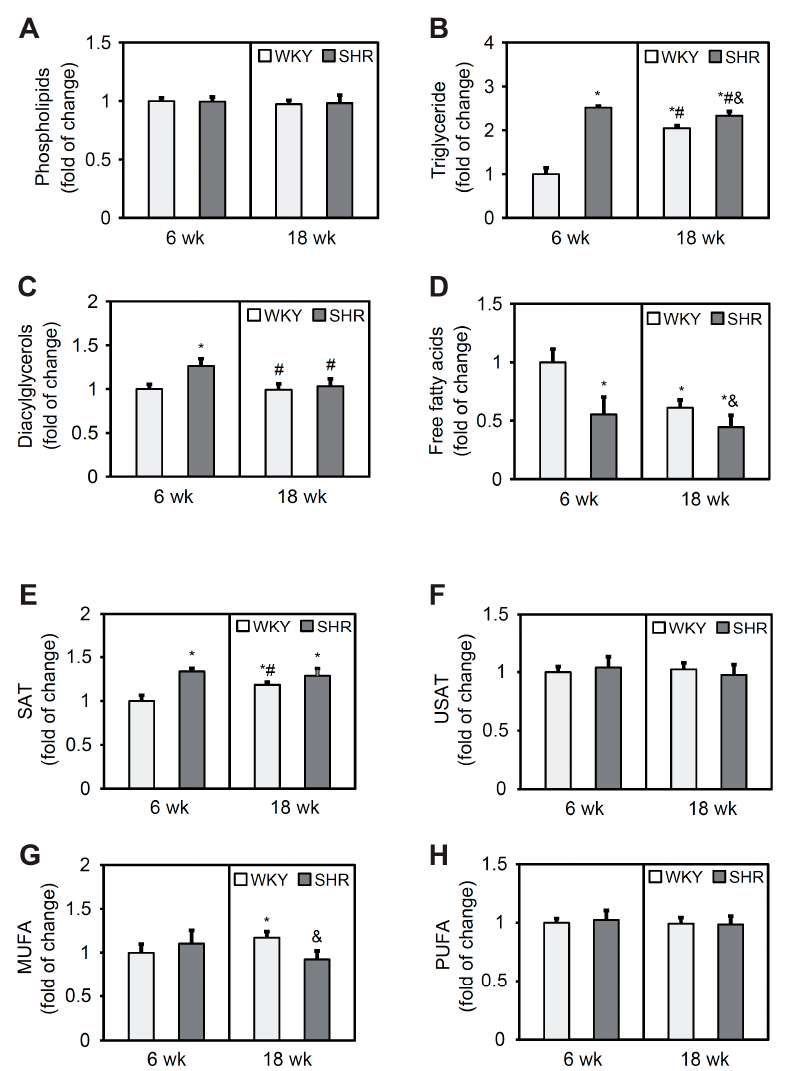
Figure 2. Phospholipid ( A ), triglyceride ( B ), diacylglycerol ( C ), free fatty acid ( D ), saturated fatty acid (SAT) ( E ), unsaturated fatty acid (USAT) ( F ), monounsaturated fatty acid (MUFA) ( G ), and polyunsaturated fatty acid (PUFA) ( H ) content in the left ventricle in WKY rats and SHRs at 6 and 18 weeks of age. Lipids were extracted from the heart, separated by thin-layer chromatography, and quantified by gas-liquid chromatography. The results are expressed as mean ± SD. n = 10. * p < 0.05, vs. WKY6 group; # p < 0.05, vs. SHR6 group; & p < 0.05, vs. WKY18 group.